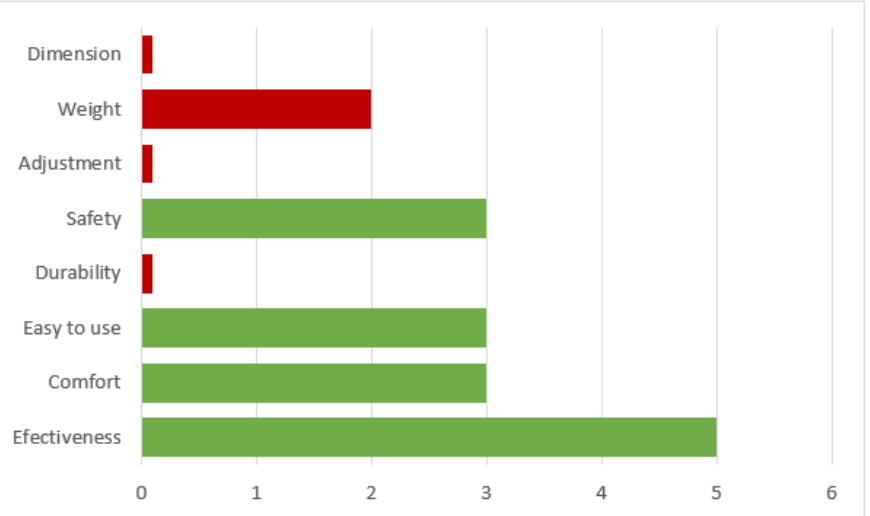
Figure 5. Results of the Quebec User Evaluation of Satisfaction with assistive Technology 2.0 test. The score of each topic refers to the number of participants who considered that characteristic relevant. (Green indicates more than half of the participants, while red indicates less than half of the participants.).